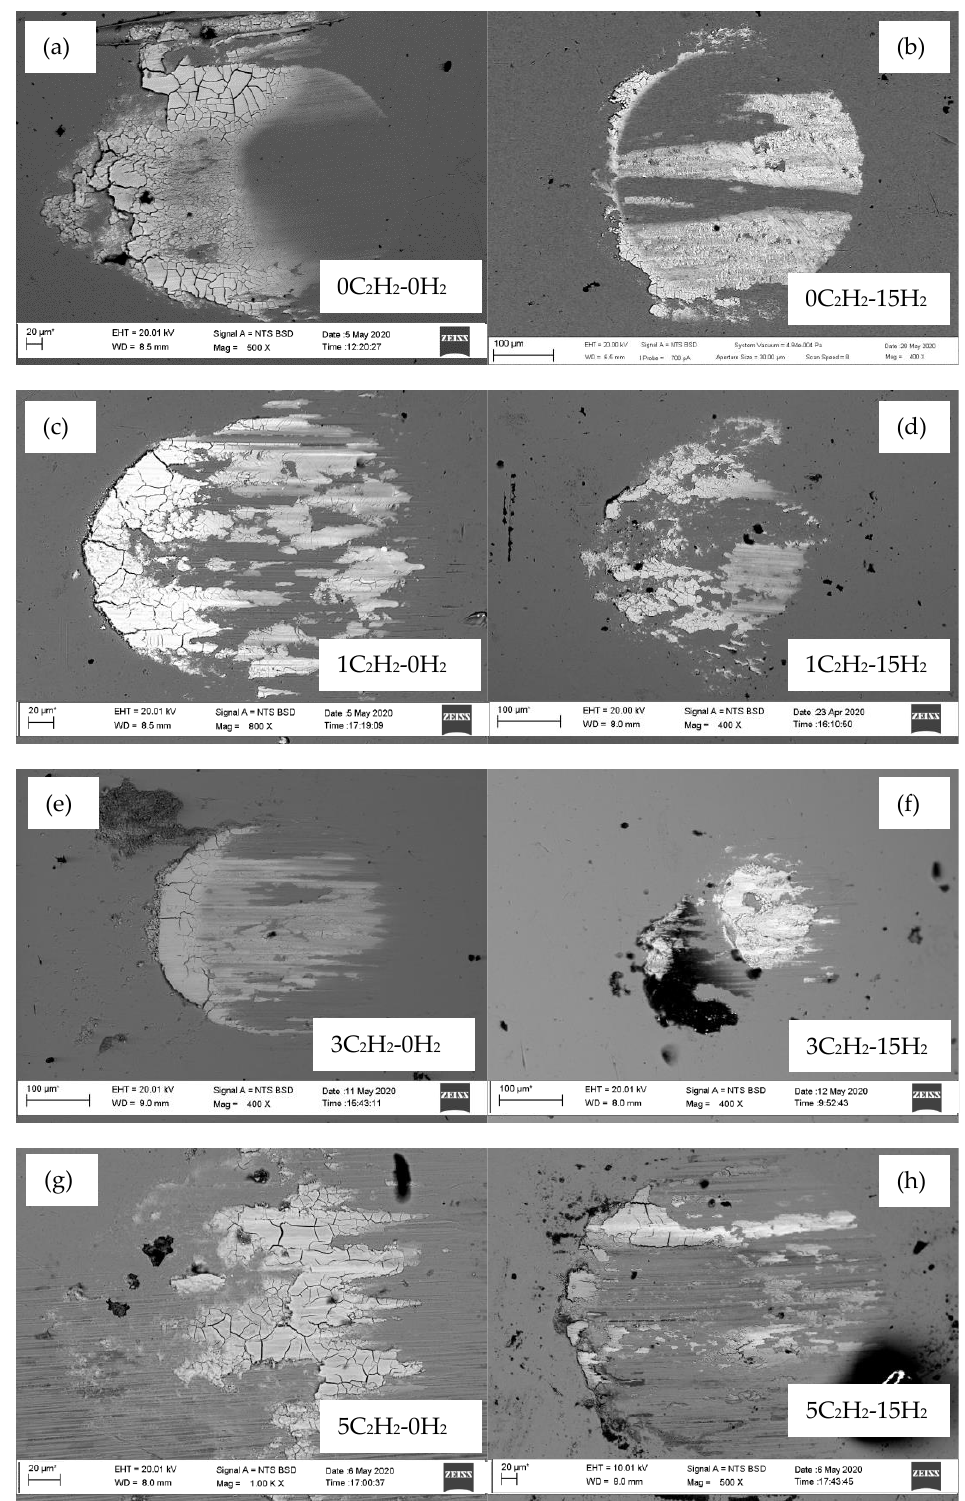
Figure 12. Summary of the backscattered SEM micrographs of the wear scars after long-term friction tests in the coatings deposited with different flows of reactive gases in the Ar sputtering atmo- spheres: ( a ) reference non-hydrogenated W-C coating with 0 C 2 H 2 + 0 H 2 flows, ( b ) 0C 2 H 2 + 15H 2 , ( c ) 1C 2 H 2 + 0H 2 , ( d ) 1C 2 H 2 + 15H 2 , ( e ) 3C 2 H 2 + 0H 2 , ( f ) 3C 2 H 2 + 15H 2 , ( g ) 5C 2 H 2 + 0H 2 (in SE mode) and ( h ) 5C 2 H 2 + 15H 2 . Note the variations of the magnification among different